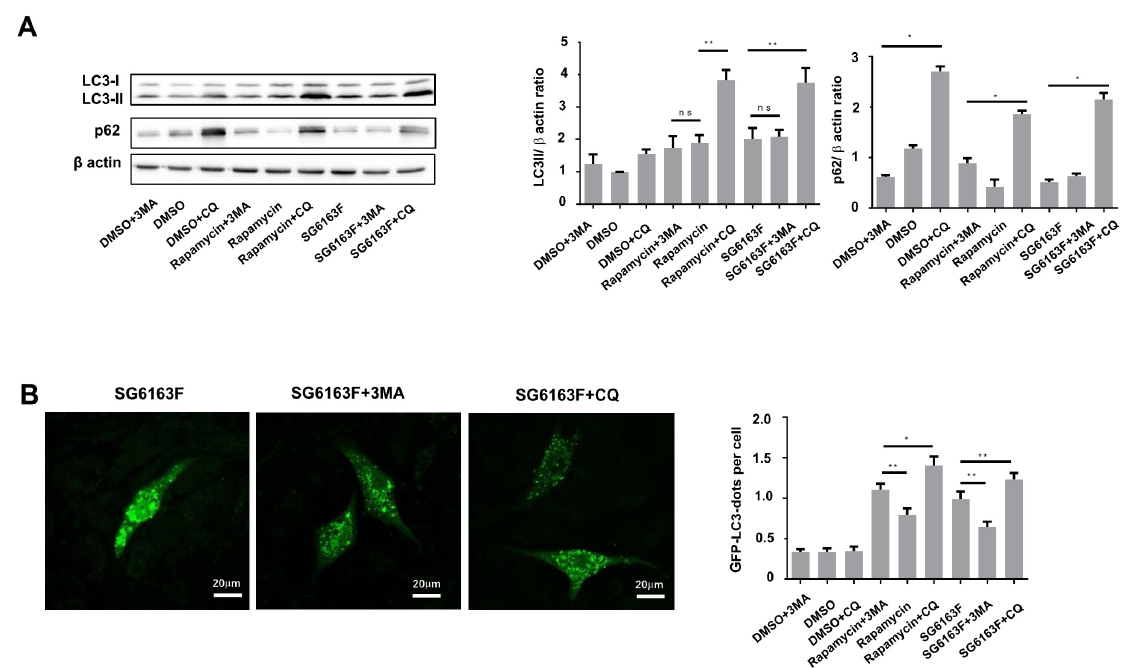
Figure 5. SG6163F stimulates autophagic flux in RNVCs. ( A ) Protein levels of LC3-I/II and p62 in RNVCs treated with 5 mM 3-methyladenine (3MA) and 20 µM chloroquine (CQ) and 10 µM SG6163F or 3µM rapamycin for 6 h were analyzed by Western blot. LC3II/ β -actin and p62/ β -actin ratios were determined and presented as fold change in comparison to DMSO. Data are presented as mean ± SEM with one-way ANOVA, Sidak’s multiple comparisons test. *, p < 0.05, **, p < 0.01. ( B ) Upon cell transfection by GFP-LC3 for 24 h and 6 h of cell treatment by SG6163F, 3-methyl adenine (MA), chloroquine (CQ), and rapamycin (not shown as image), GFP-LC3 redistribution to vacuoles (dots) was visualized by fluorescence microscopy and quantified by Image J. Experiments were repeated three times. Data are presented as mean ± SEM with one-way ANOVA, Sidak’s multiple comparisons test, *, p < 0.05, **, p < 0.01, ns, no significant.